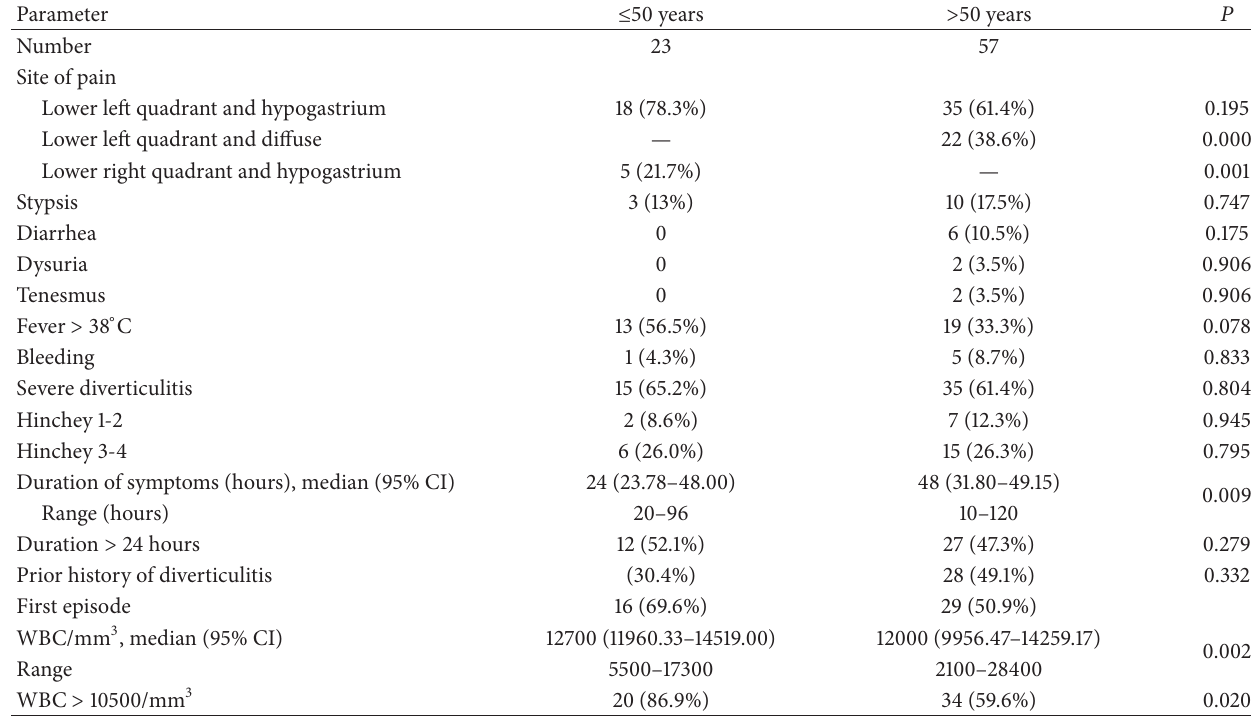
Table 3: Patients’ symptoms, signs, and complications.